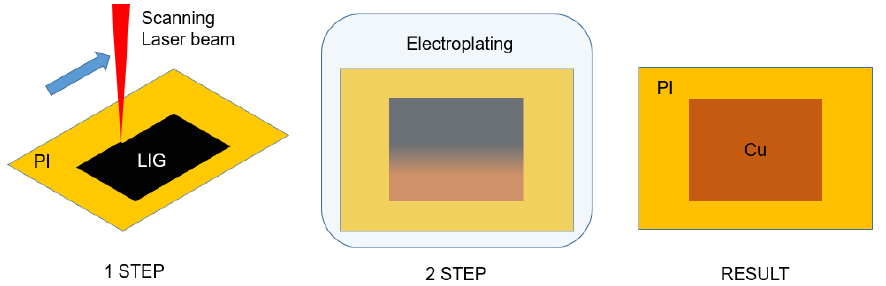
Figure 1. Schematic of two-step copper deposition process on polyimide (PI). Surface conductivity measurements and Raman spectroscopy were applied to charac- terize the laser-modified polymer surface. Then, electroplating parameters were varied